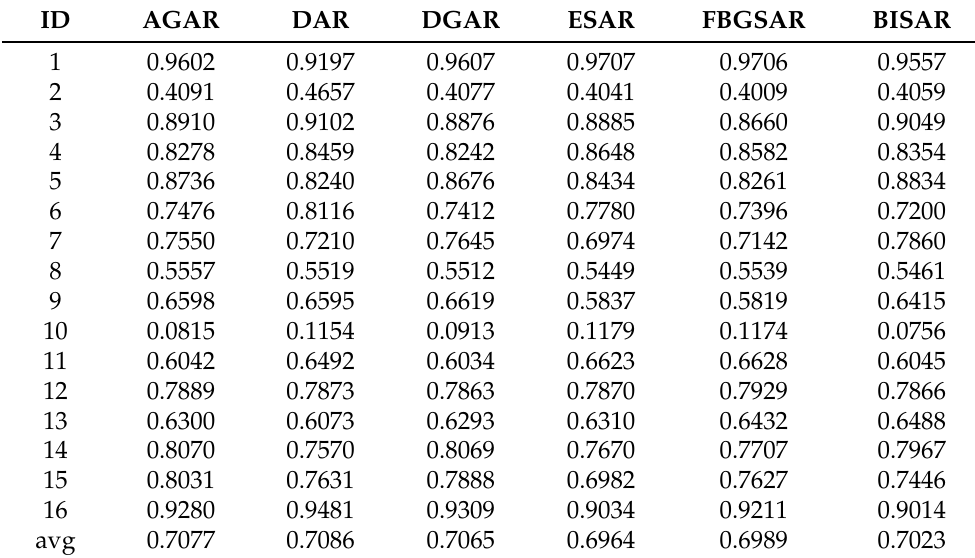
Table 12. Classification accuracies based on SVM classifier (label noise).